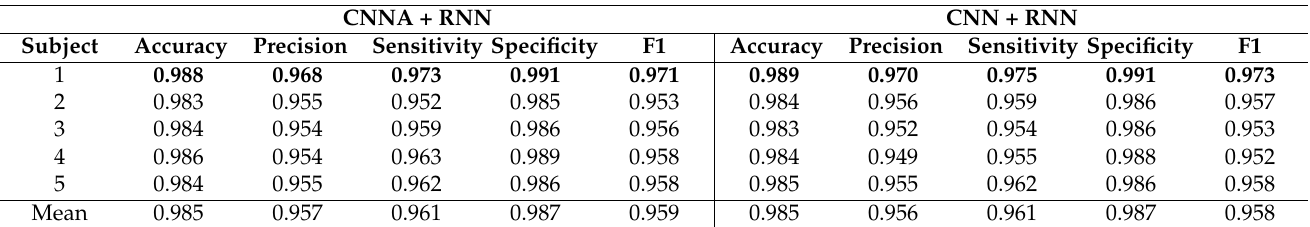
Table 8. RAW dataset evaluation.